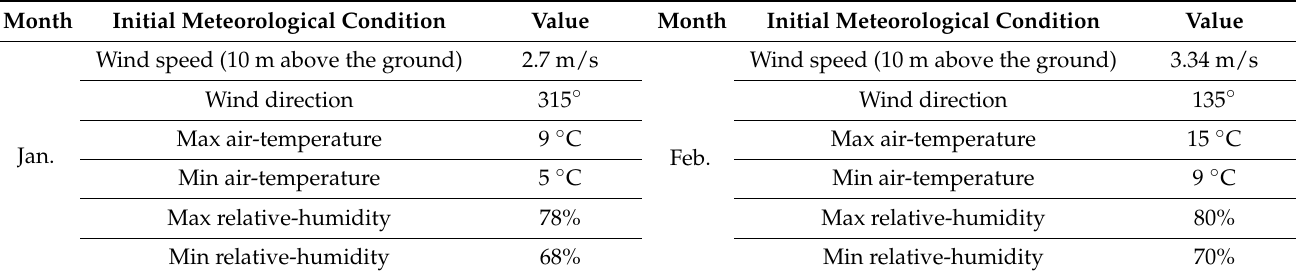
Table 4. Boundary conditions of the